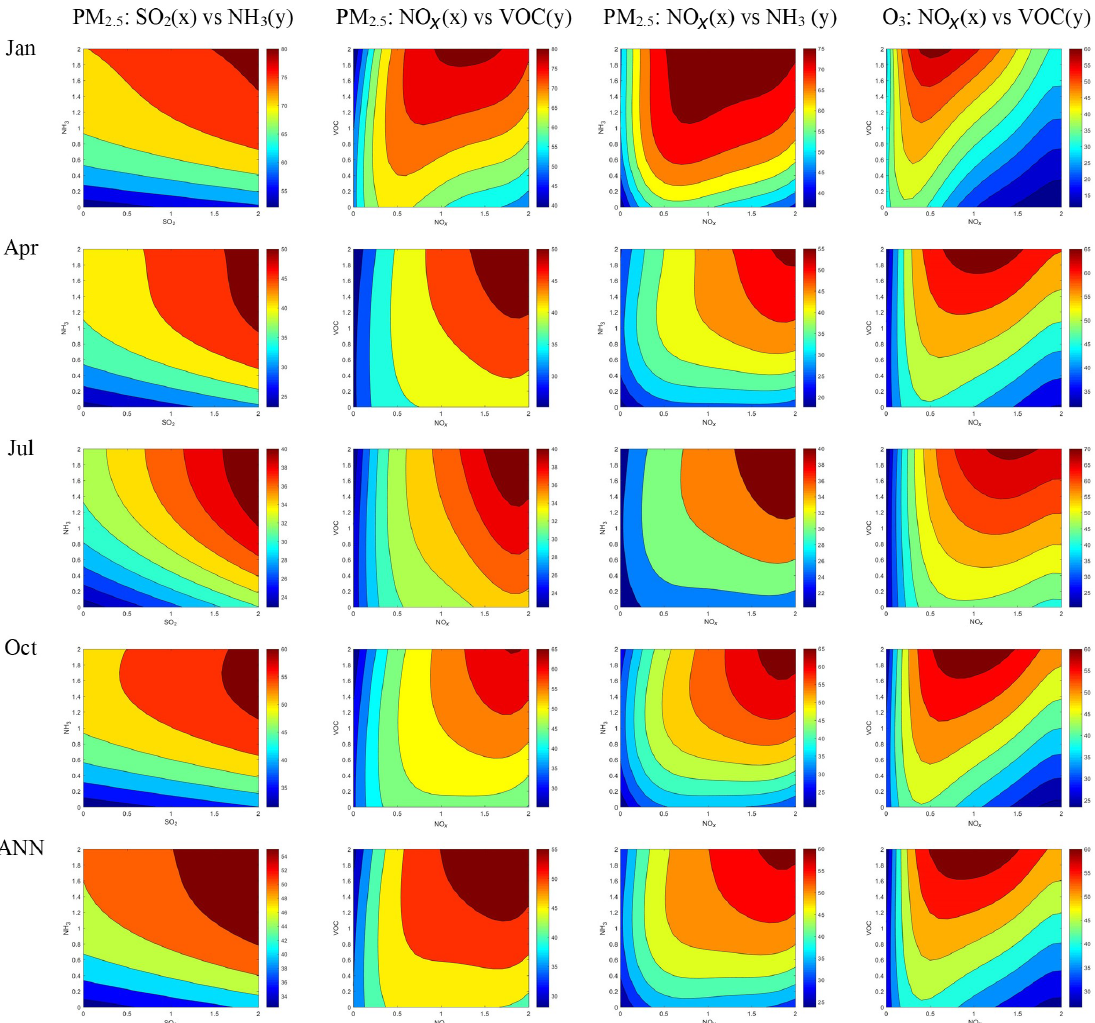
Figure 3. Isopleth of population-weighted PM 2 . 5 and daytime O 3 to precursor emission change in different months. (The x and y axes represent precursor emission rates with a baseline of 1, applied to all grid cells in China; background colors represent the population- weighted PM 2 . 5 and daytime O 3 concentrations in China, with units of micrograms per cubic meter for PM 2 . 5 and parts per billion for O 3